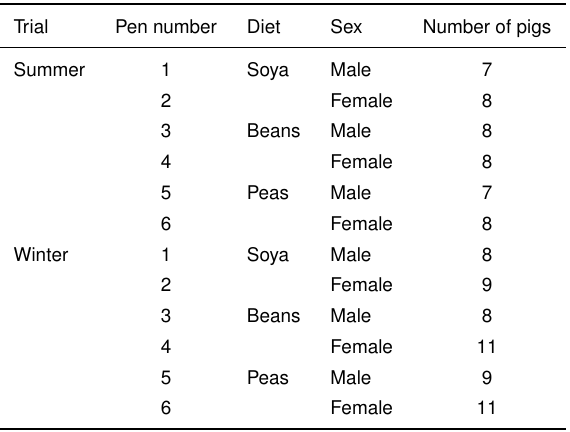
Table 1. Arrangement of pens as part of the feed trial to compare silage-based rations including different protein sources (diet).